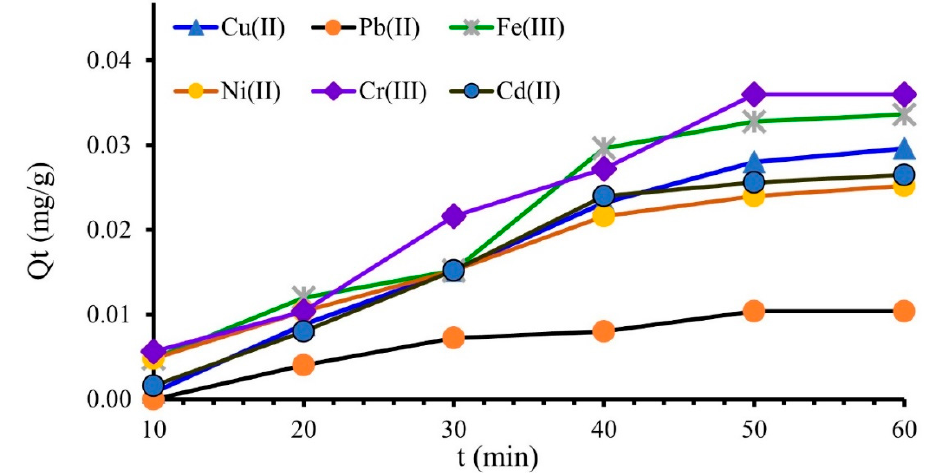
Figure 2. Influence of contact time on the retention of metal ions onto MS mass, 0.04 L of M X+ ( Ci = 0.5 mg/L), contact time 10–60 min, 0.5 g MS, 175 rpm (25 ± 2 °C), pH = 4.2 .